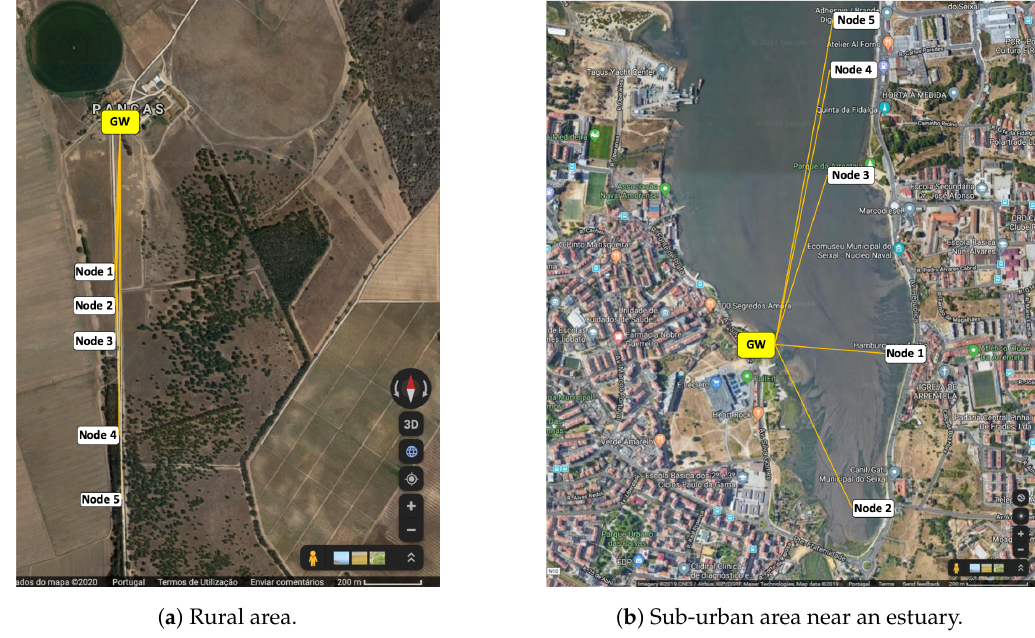
Figure 5. Physical location of nodes.